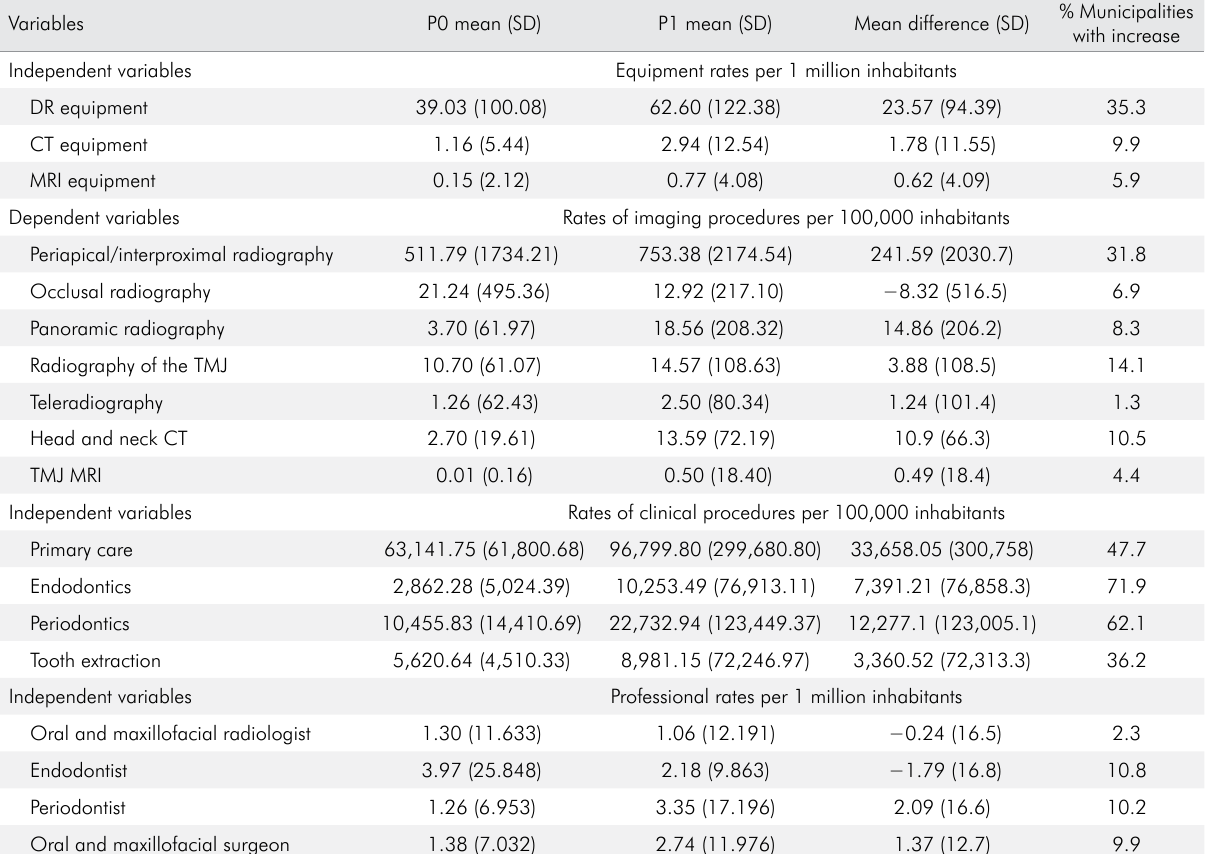
Table 1. Means and standard deviations (SD) of the rates of variables related to dental imaging in public between periods P0 (2005–2007) and P1 (2014–2016) in all Brazilian municipalities (n =